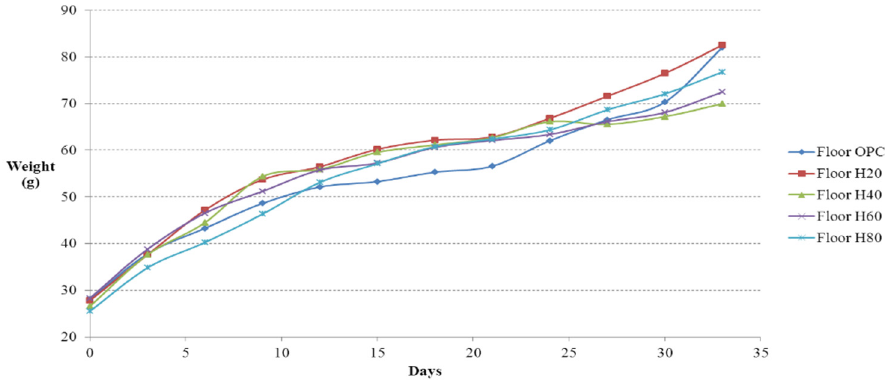
Figure 15. Weight change versus time curves (floor cages).